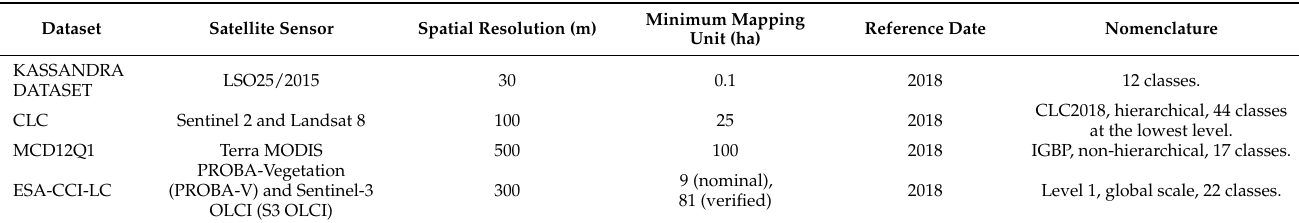
Table 1. Overview of the datasets examined in this study.